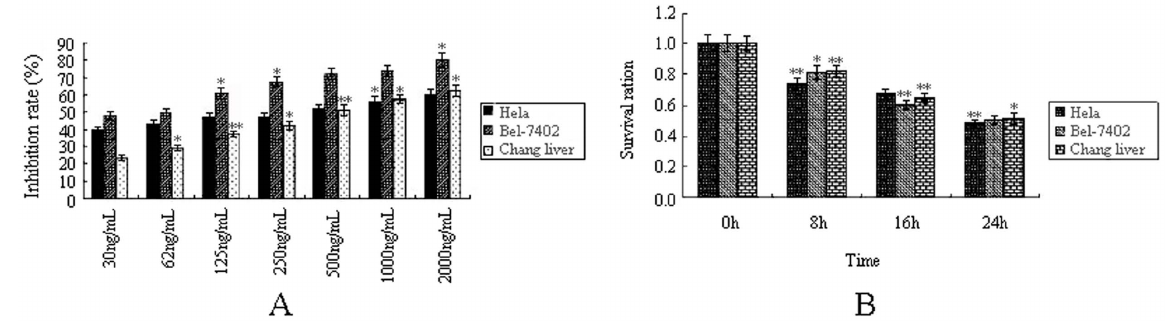
Figure 1. The inhibition effect of T-2 toxin on three cell strains. A . Dose-dependent inhibition ration of T-2 toxin at 24 h. B . Time-dependent effect of T-2 toxin to cells. Data was presented as mean 6 SD. *p , 0.05, **p , 0.01, ***p , 0.001.